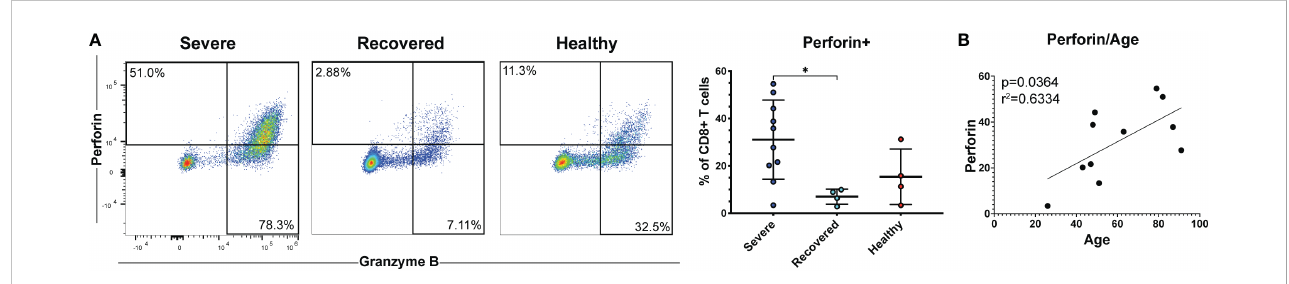
FIGURE 4 Severe COVID-19 patients have greater frequencies of perforin+ CD8+ T cells. (A) The frequencies of CD8+ T cells (viable, CD14-, CD56-, CD19-, CD3+, CD8+ cells) expressing perforin in non-severe and severe COVID-19 patients, recovered COVID-19 patients, and healthy controls were assessed by fl ow cytometry. (B) Correlation between age and perforin+ CD8+ T cells. *p<0.05 one-way ANOVA with multiple comparisons